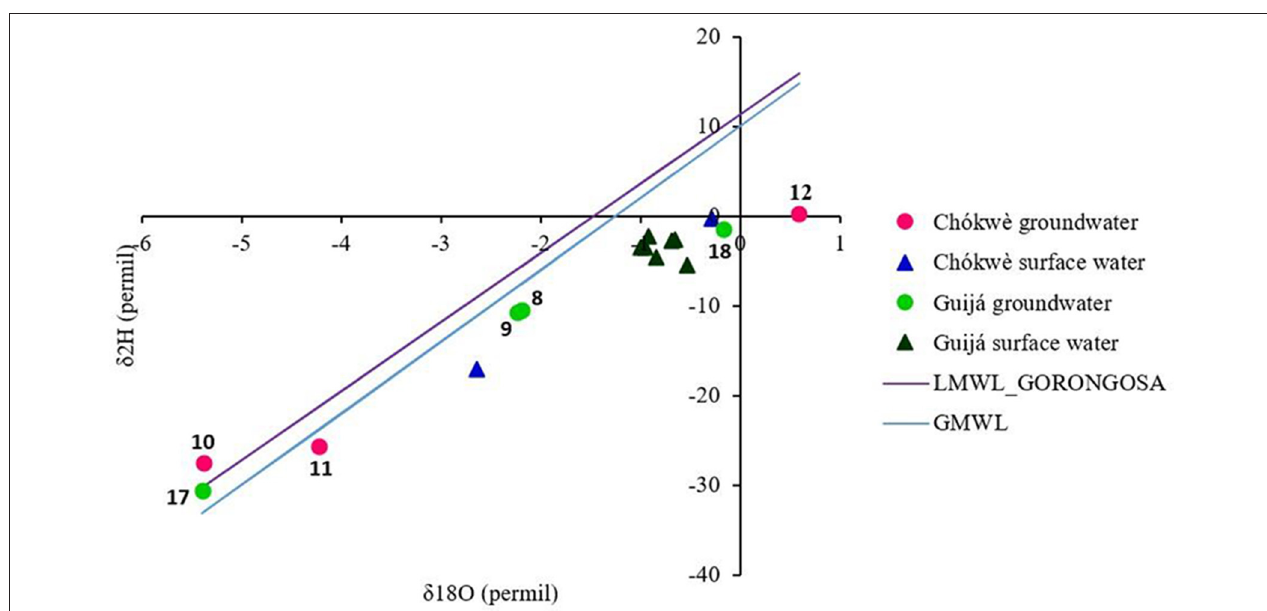
FIGURE 12 | Plot of δ 2 H vs. δ 18 O for the surface and groundwater samples at the two study sites. The data source of LMWL of Gorongosa is the Global Network of Isotopes in Precipitation (GNIP) provided by the International Atomic Energy Agency (IAEA).